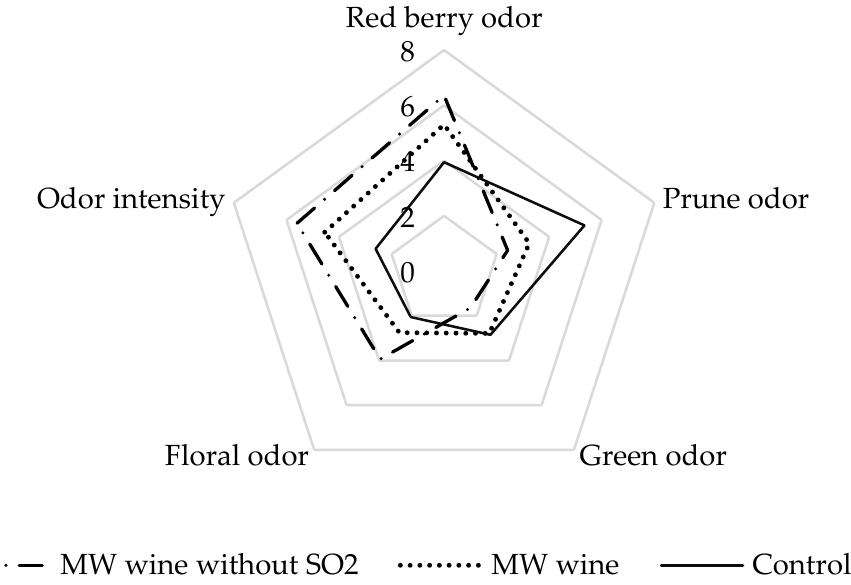
Figure 3. Olfactory attributes scores of control wines and wines from microwave maceration elab- orated with and without SO 2 . “Control wine”: no treatment applied; “MW wine”: microwave treatment at 700 W, 12 min of grape crushed; “MW wine without SO 2 ”: microwave treatment at 700 W, 12 min of grape crushed, elaborated without SO 2